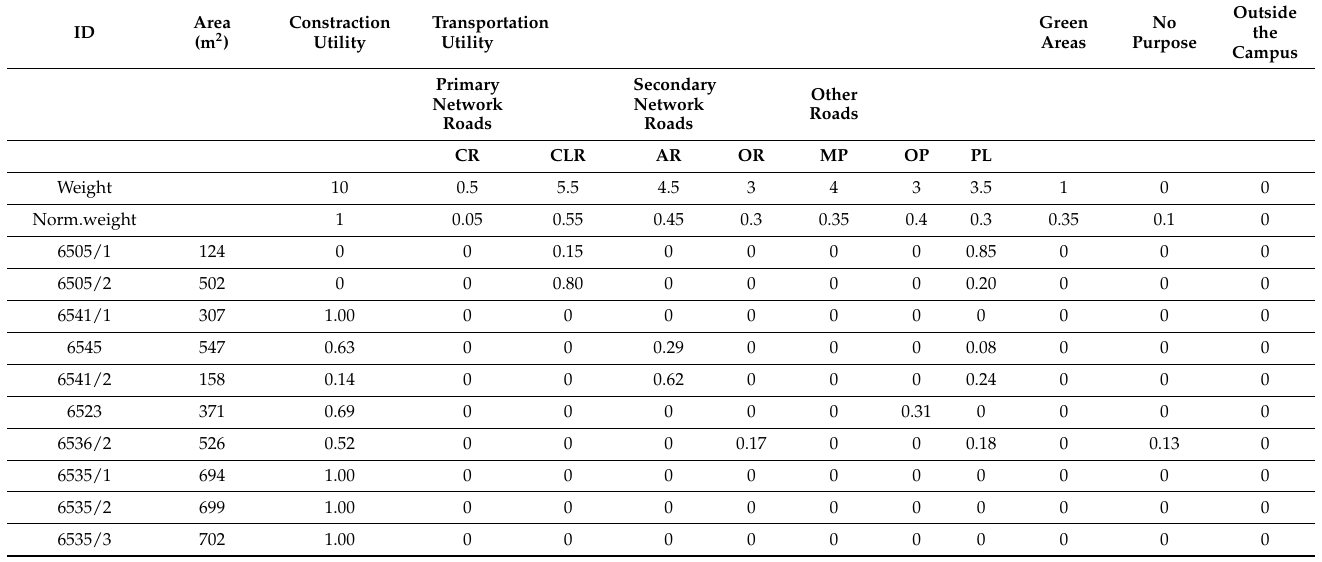
Table 4. Statement of the cadastral parcels through the percentage shares of the cadastral parcel parts areas according to each use and purpose in the Campus project of the University of Split.